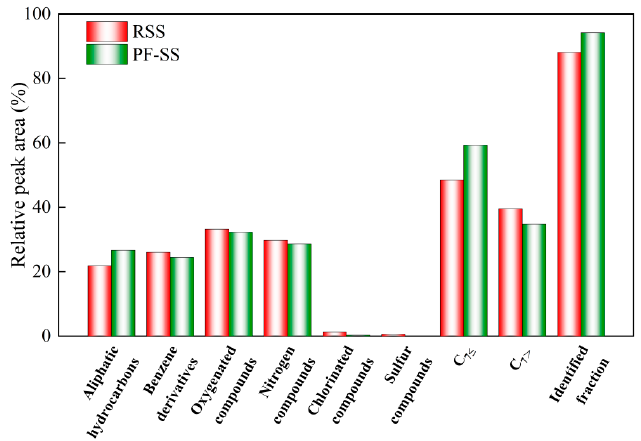
Figure 6. Classi fi cation and percentage peak areas for the identi fi cation of PF-SS and RSS according Figure 6. Classification and percentage peak areas for the identification of PF-SS and RSS according to the pyrolysis chromatogram. to the pyrolysis